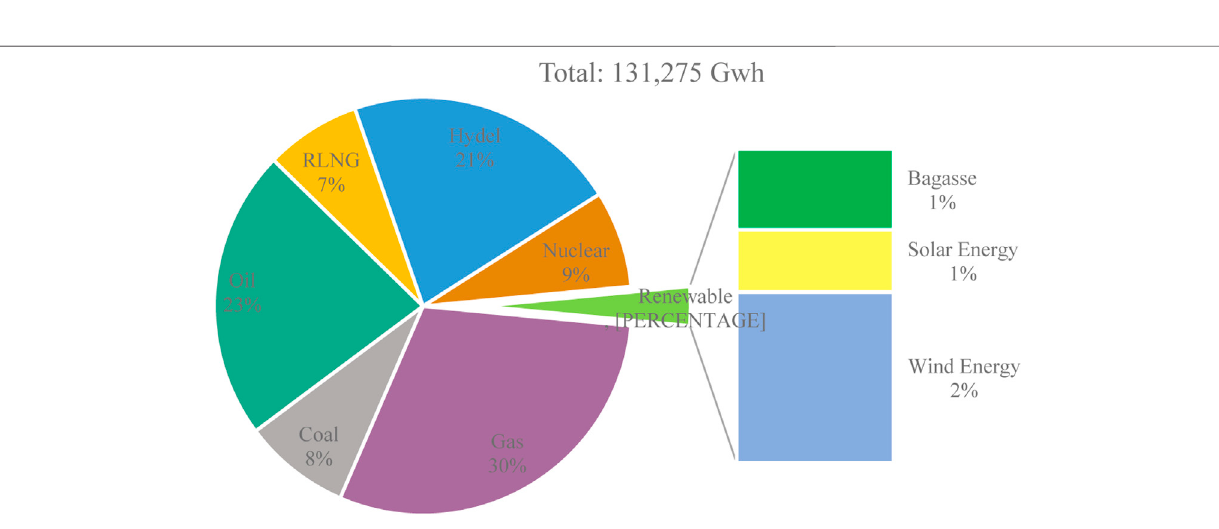
Frontiers in Energy Research |